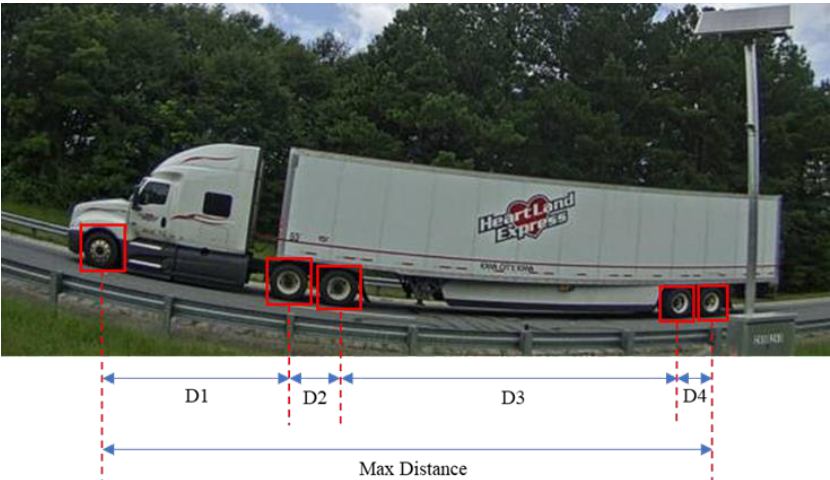
Figure 2. Examples of vehicle images in the dataset. ( a ) Vehicle images from the ImageNet. ( b ) Vehicle images collected at the GDOT WIM sites.